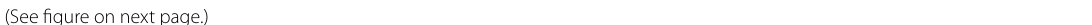
Fig. 1 Maps showing the overall setting of the drill site of core GS-UR-1. a The marine and atmospheric environment around the Japanese islands, including the study site, is shown in this figure. The blue and red arrows represent the paths of the Oyashio and Kuroshio currents. The core sites referred to in this study are also shown. This base map was generated using Generic Mapping Tools. (b) Topography and geology around the core site. The sampling location of the core KT12-06-2B (Kajita et al. 2020b) is also shown. The base map was generated using the Seamless Digital Geological Map of Japan (Geological Survey of Japan, AIST